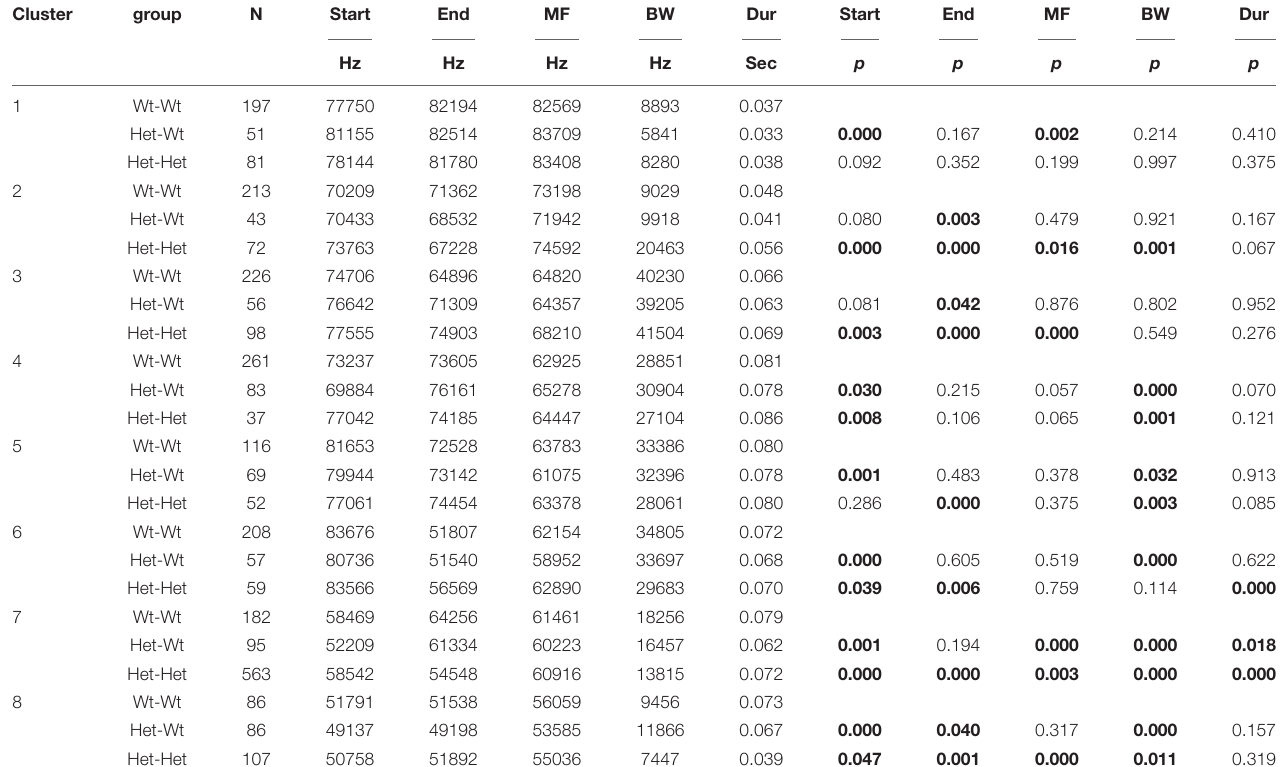
TABLE 4 | The effect of Mthfr genotype on spectral and temporal properties of isolation induced syllables of the different syllable clusters in male pups. Cluster